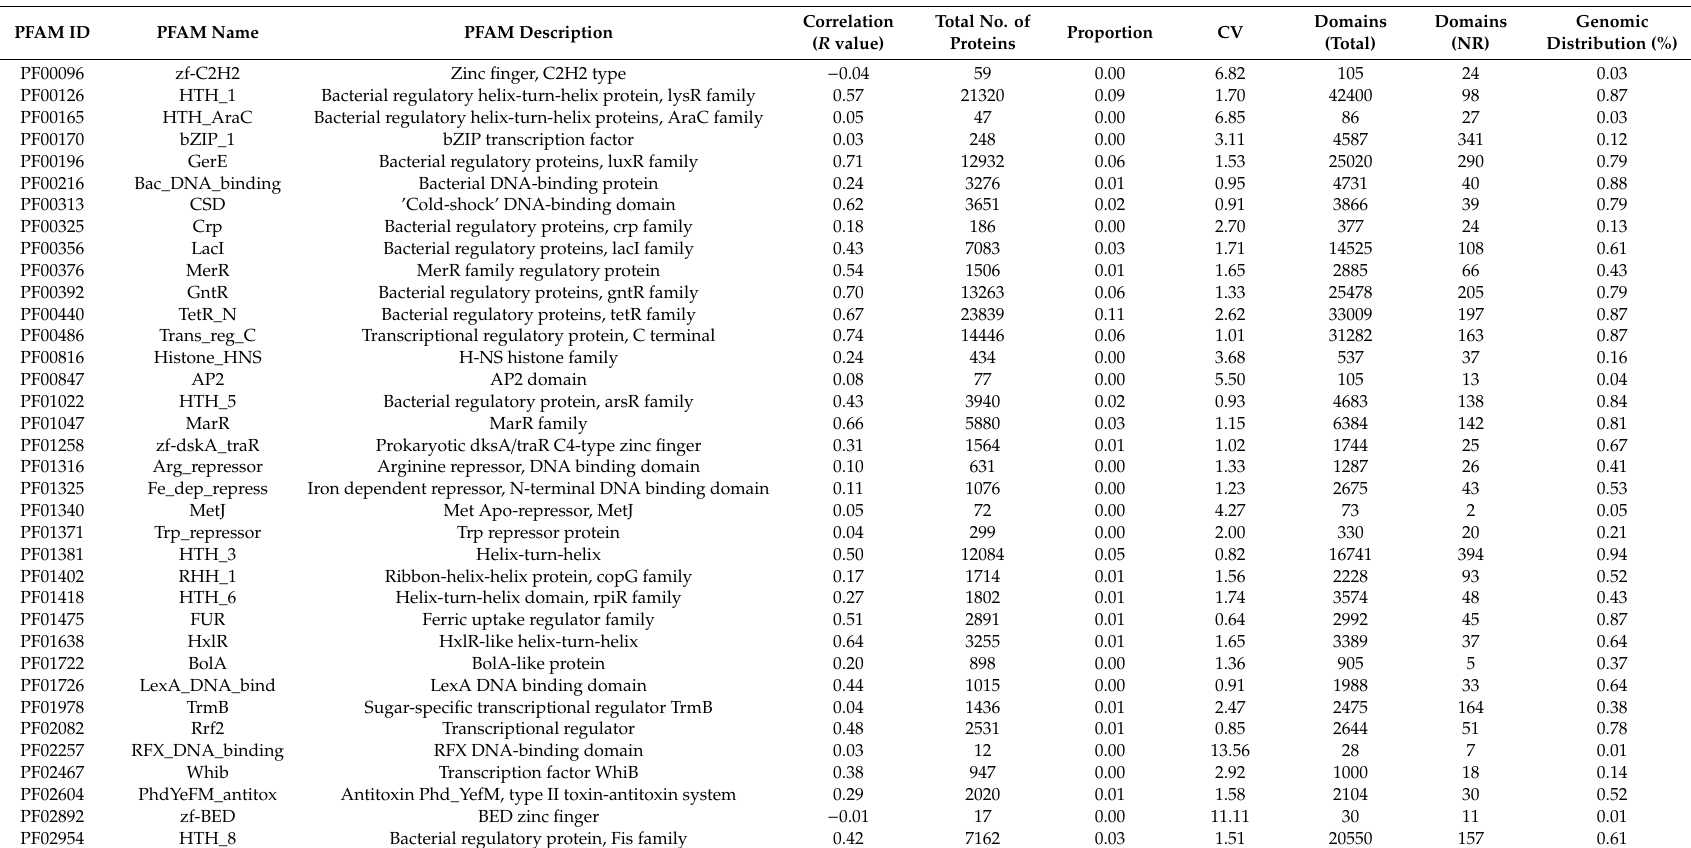
Table 1. Families evaluated in this work. Columns are as follows: PFAM ID, PFAM Name and PFAM Description: R -value (correlation between genome size and PFAM distribution); Total number of members in the bacterial and archaeal genomes; Proportion of the PFAM (%) relative to the complete collection; PFAM Coe ffi cient of Variation (CV); Number of total of domains; Number of di ff erent domains (NR); PFAM Distribution (%) among all the